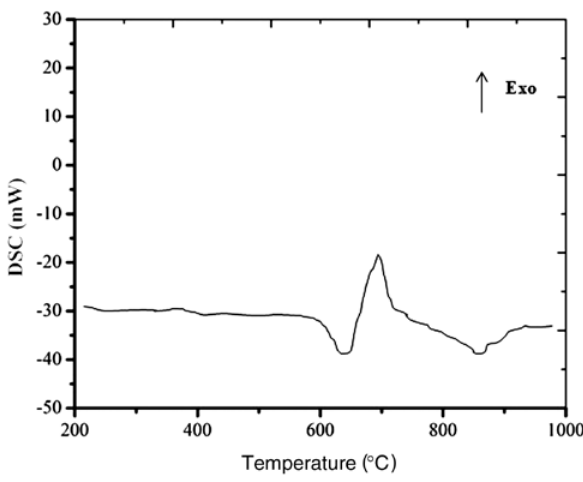
Figure 1: Differential scanning calorimetry (DSC) analysis of Al and V O . 2 5